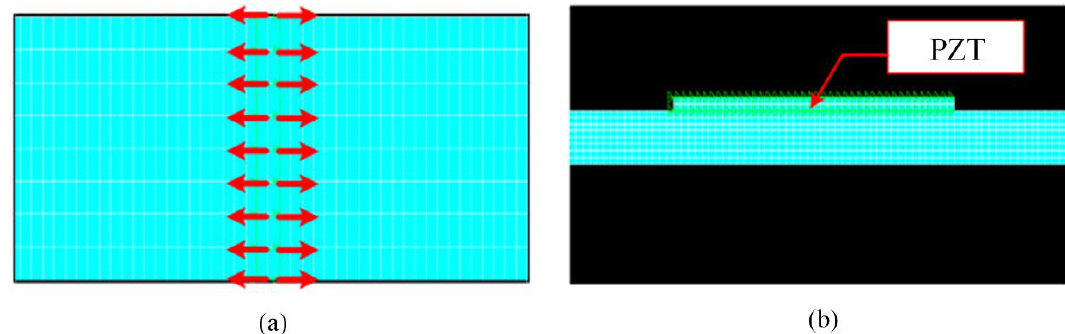
Figure 4. The simulation model: ( a ) dipole moment diagram; ( b ) overall model.